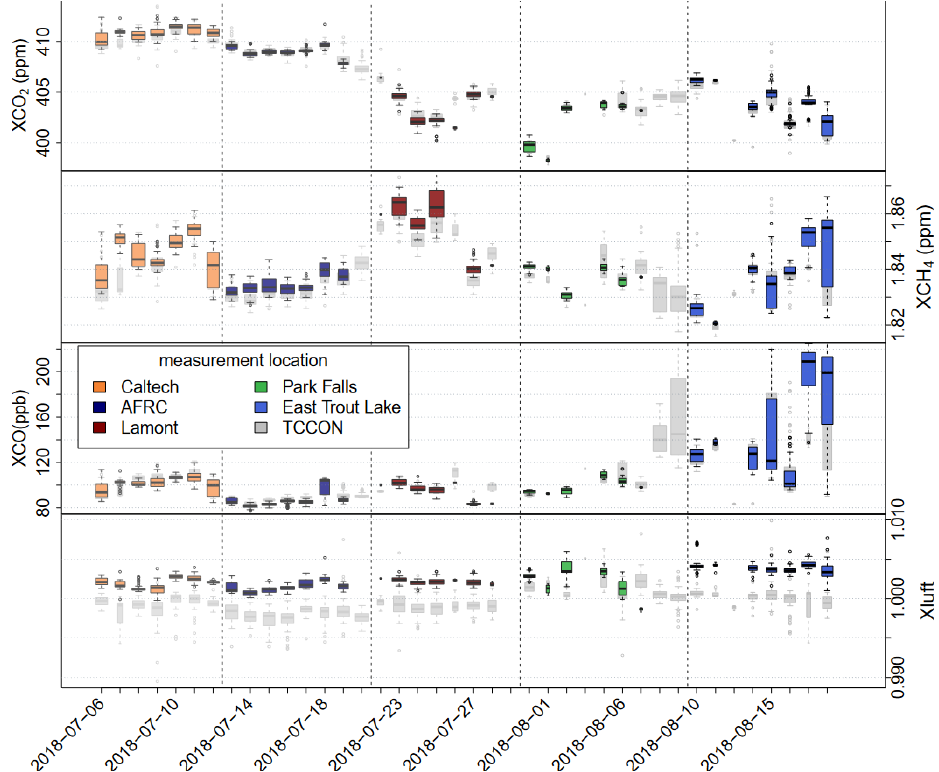
Figure 8. Time series of EM27/SUN (tb) retrieved XCO 2 , XCH 4 , XCO, and Xluft in colour and co-located TCCON in transparent grey during the summer 2018 campaign (GGG2020). Different sites are highlighted by a different colour. Vertical dashed lines represent the dates in which the instruments were moved to the next TCCON station. The box plot width is proportional to the number of observations collected in each day. The line inside each box represents the median value for each day, and the bars show the daily range, excluding the outliers. Outliers are depicted as dots. Table 7. This table lists the maximum EM27/SUN TCCON and EM27/SUN low-resolution (LR) TCCON biases throughout the 2018 campaign. The maximum biases are calculated by taking the difference between the minimum and maximum 10min averaged biases between the EM27/SUN and each TCCON site. The maximum MAD is the maximum of all the MADs in the 10min averaged EM27/SUN TCCON biases. This table shows these values for retrievals performed using both GGG2014 and GGG2020. Maximum EM27/SUN TCCON biases, for which Eureka data from 2020 Arctic campaigns are included, are shown in